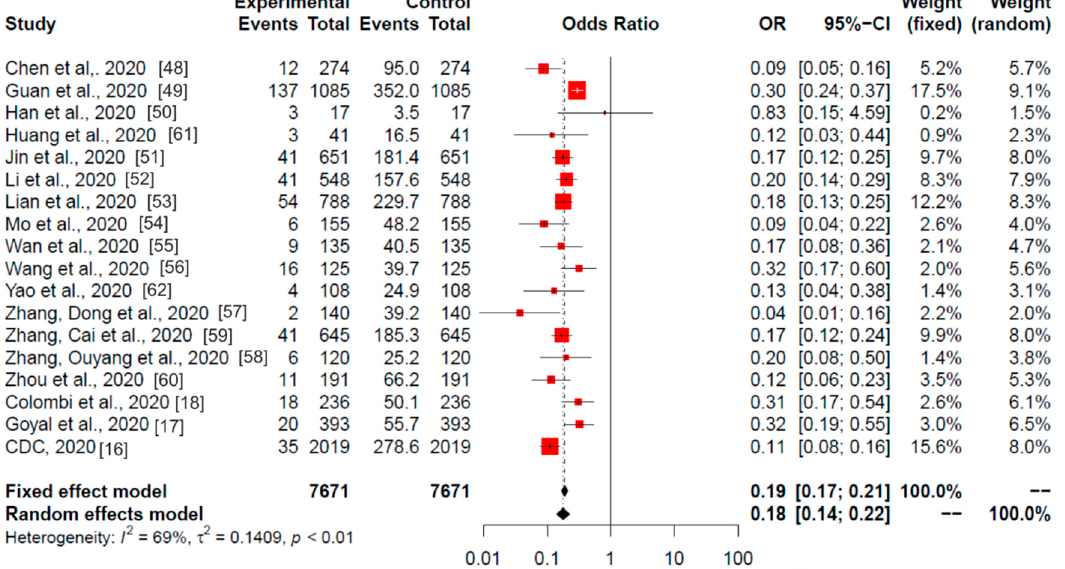
Figure 3. Global meta-analysis (China, Italy, and USA studies). Odds ratios of current smoking (experimental) among hospitalised (control) patients with COVID-19 are shown. The analysis included all (18) studies selected in the systematic review. Red squares area is proportional to the size of the sample data. Black crosses and horizontal lines represent OR and 95% CI, respectively.